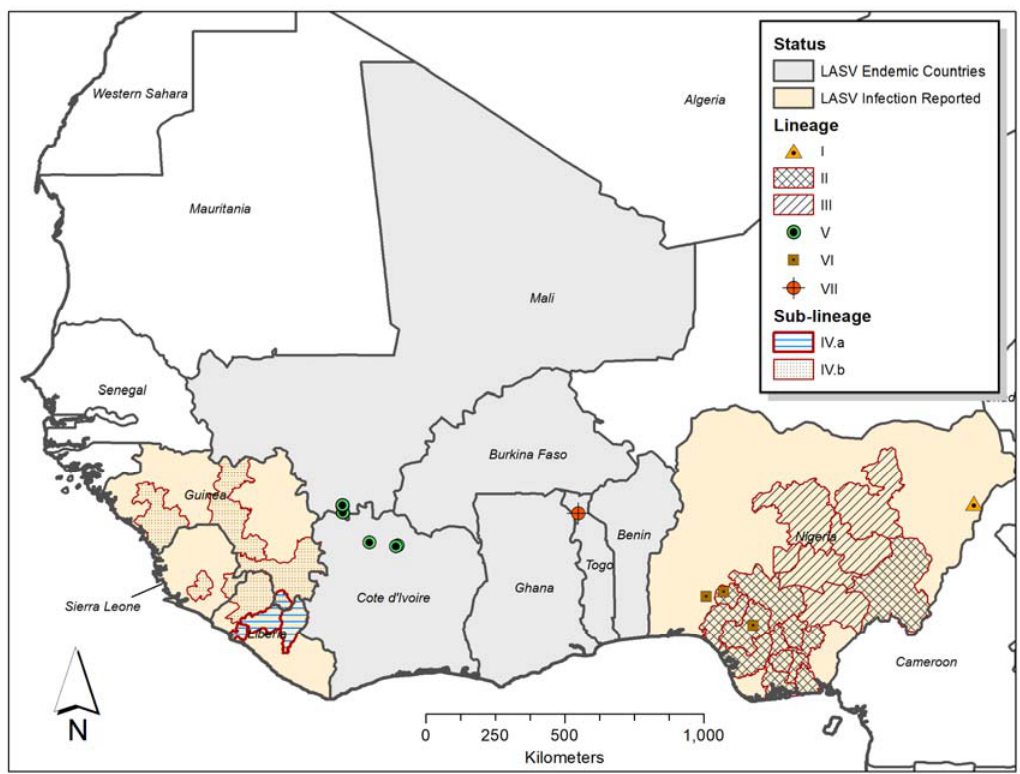
Figure 1. Geographical distribution of Lassa virus (LASV) Lineages in West Africa. The shaded areas and symbols on the nap show the distribution of LASV lineage and sub-lineage infections as observed in West Africa, based on data from Ehichioya et al., 2019 and Wiley et al., 2019 [17,18]. The shaded areas depict administrative regions / states within LASV endemic countries, where each represented LASV lineage (II and III) or sub-lineage (IV.A and IV.B) has been reported. The symbols show the locations where LASV lineages I, V, VI, and VII have been observed. Note: Shaded areas and symbols do not represent the incidence or prevalence of LASV infections in each location or administrative region.